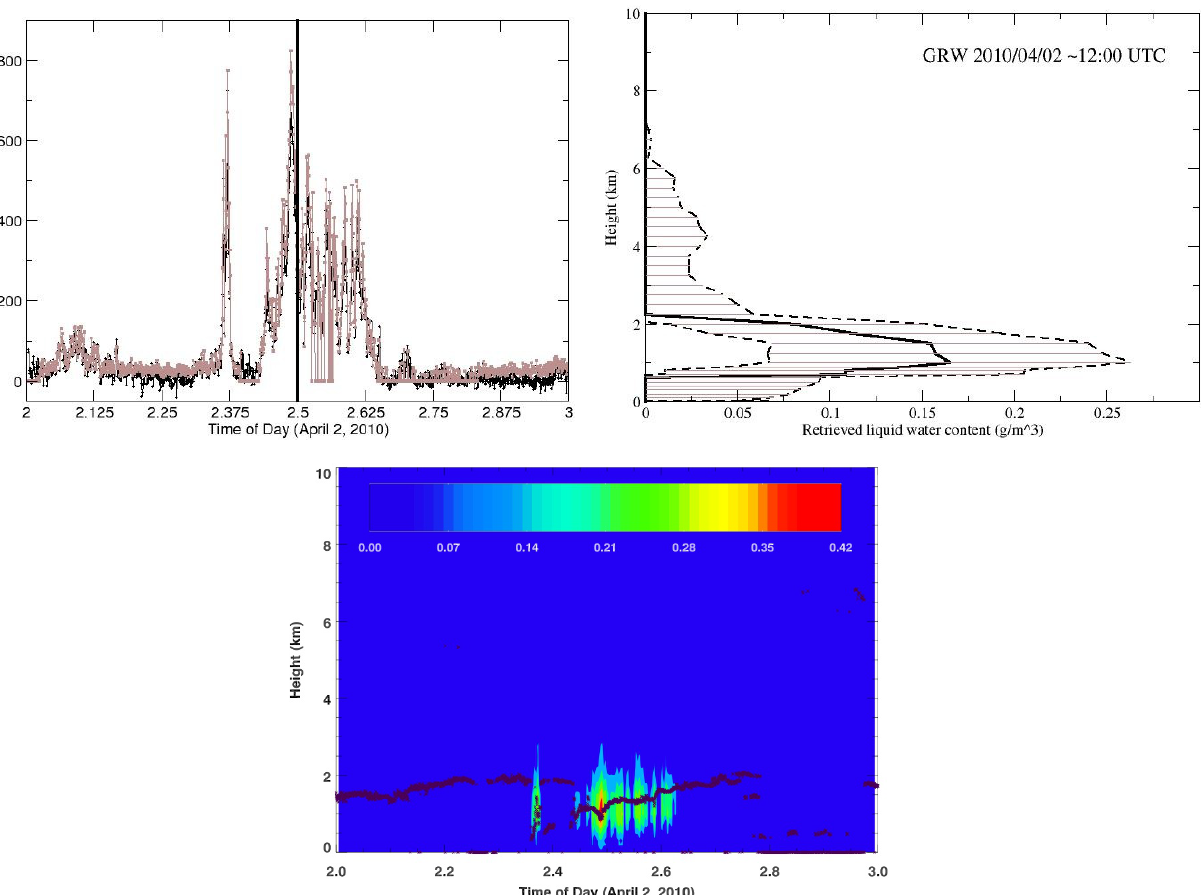
Fig. 15. Top panel: LWP on 2 April 2010 at the AMF1-Azores (black point) and LWP obtained from vertically integrating the LWC retrieval (brown points). The vertical line at 12:00UTC indicates the time of the displayed LWC retrieval in the right panel. Bottom panel: corre- sponding profiles of LWC retrieved by the MWRP and cloud base from the ceilometer. Right panel: Vertical profile of LWC retrieved by the MWRP at 12:00UTC. The black solid line is the retrieval and the area enclosed by dashed lines indicates the retrieval